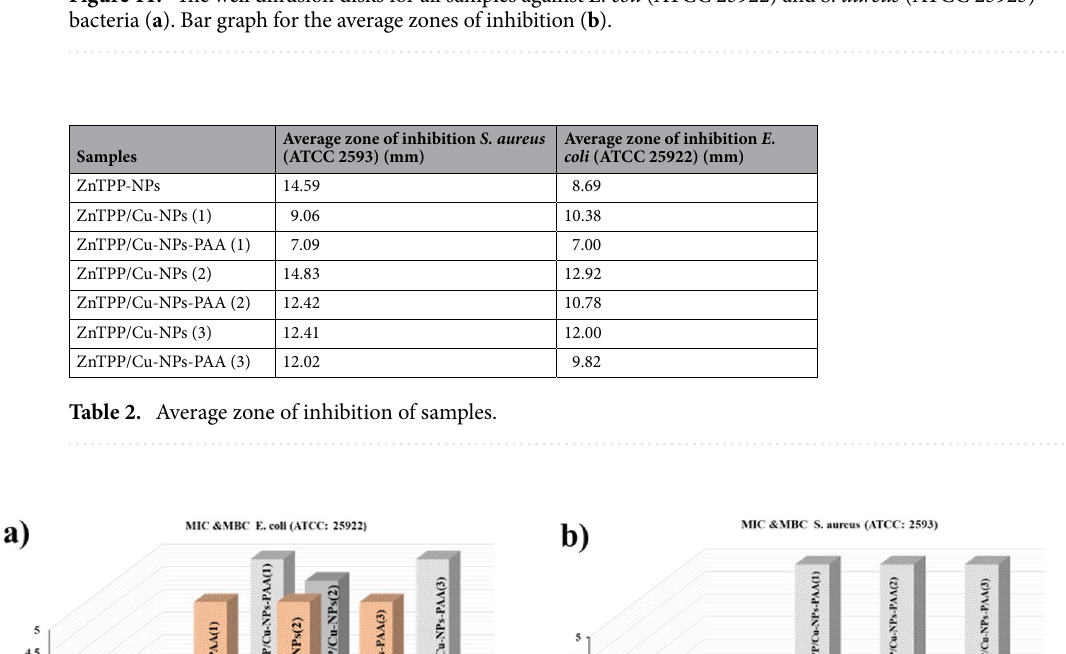
Figure 11. The well diffusion disks for all samples against E. coli (ATCC 25922) and S. aureus (ATCC 25923) bacteria ( a ). Bar graph for the average zones of inhibition ( b ).